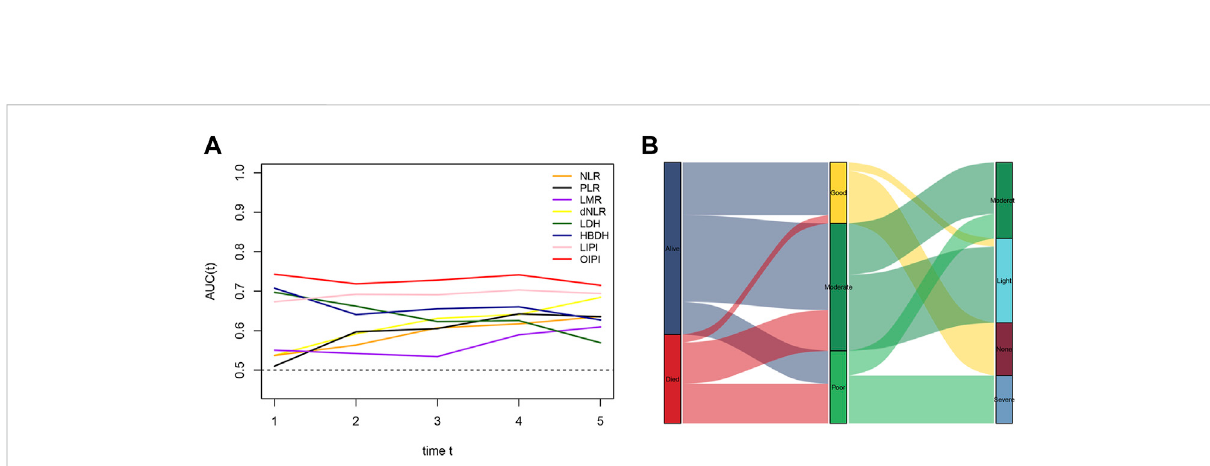
FIGURE 3 Comparison of different hematological biomarkers in predicting the overall survival. (A) The difference of predictive ability was shown in time- dependent ROC curve, in which a larger AUC value meant a better prognostic predictive ability. (B) The Sankey showed the difference between LIPI and OIPI in distributing osteosarcoma patients. NLR, neutrophil – lymphocyte ratio; PLR, platelet – lymphocyte ratio; LMR, lymphocyte-monocyte ratio;dNLR,derivedneurtrophiltolymphocyteratio;LDH,lactatedehydrogenase;HBDH,Hydroxybutyratedehydrogenase;LIPI,LungImmune Prognostic Index; OIPI, osteosarcoma immune prognostic